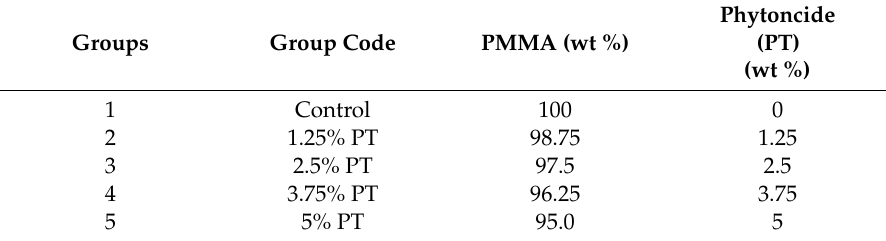
Table 1. Composition of materials in the control and experimental